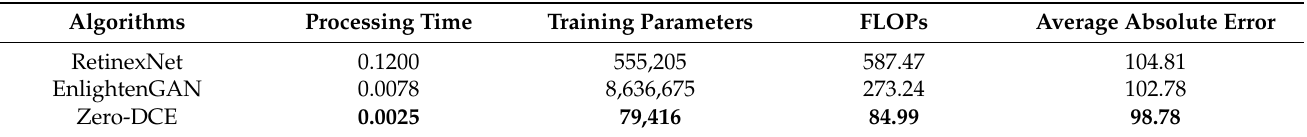
Table 1. Performance comparison of different low-light enhancement algorithms.